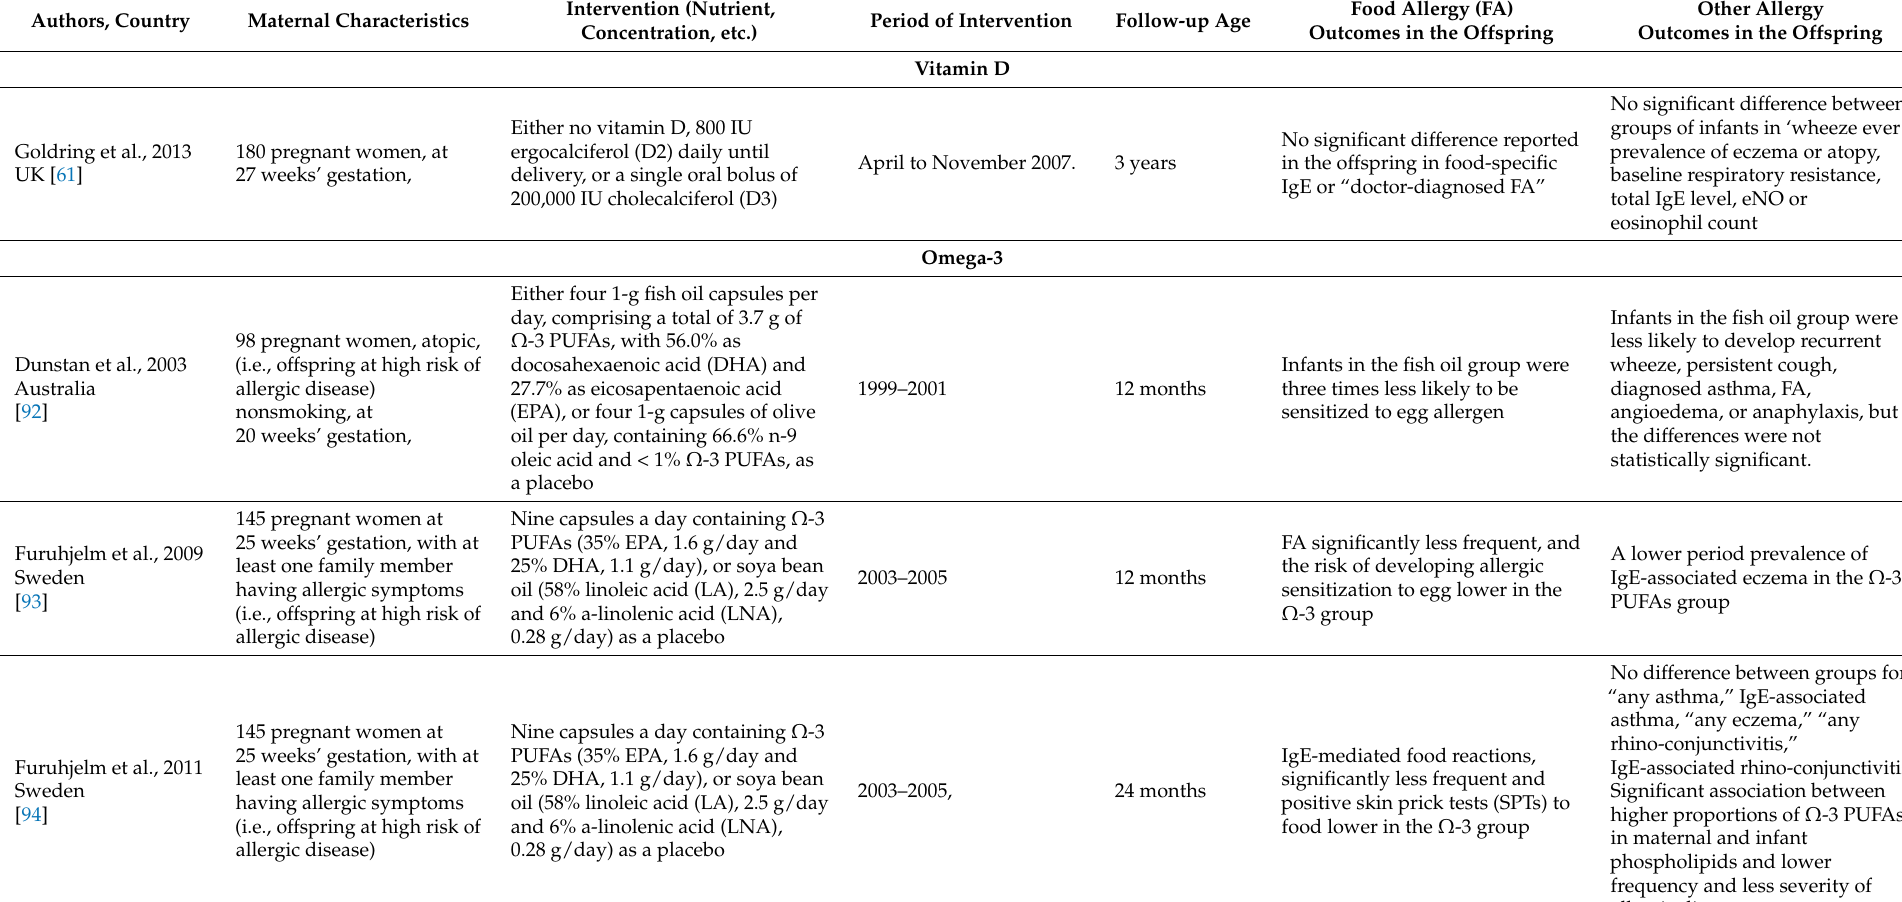
Table 1. Randomized controlled trials of maternal supplementation with vitamin D or omega-3 polyunsaturated fatty acids ( Ω -3 LC-PUFAs) during pregnancy and food allergy/sensitization to food allergens in the